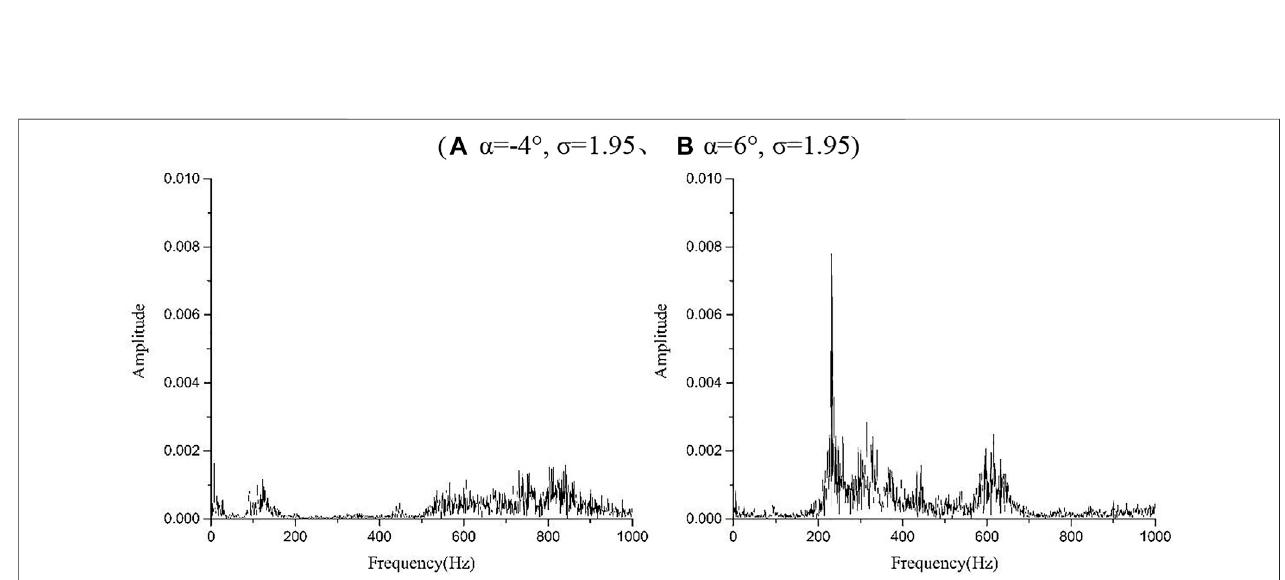
FIGURE 9 | Frequency spectra of the lift signals at non-cavitation conditions. ( (A) α (cid:1) -4 ° , σ (cid:1) 1.95 、 (B) α (cid:1) 6 ° , σ (cid:1) 1.95).